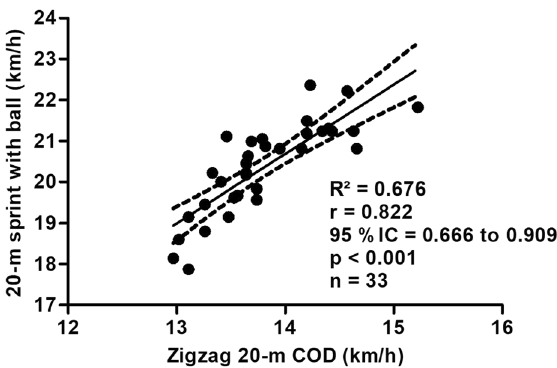
Figure 2. Substantial huge, positive, significant correlation between performance in the 20-m sprint tests with the ball and the Zigzag 20-m change-of-direction (COD) test of professional female soccer players.